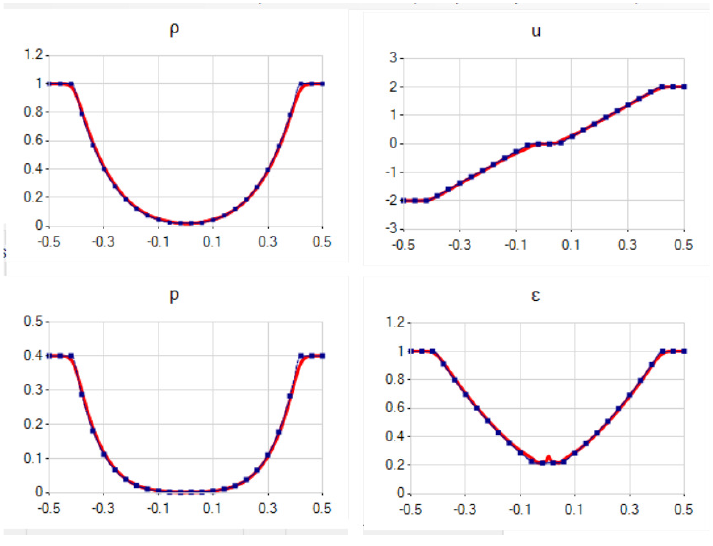
Figure 3. Test 2. Solutions for α = 0 . 018, β = 0 . 2 and N =